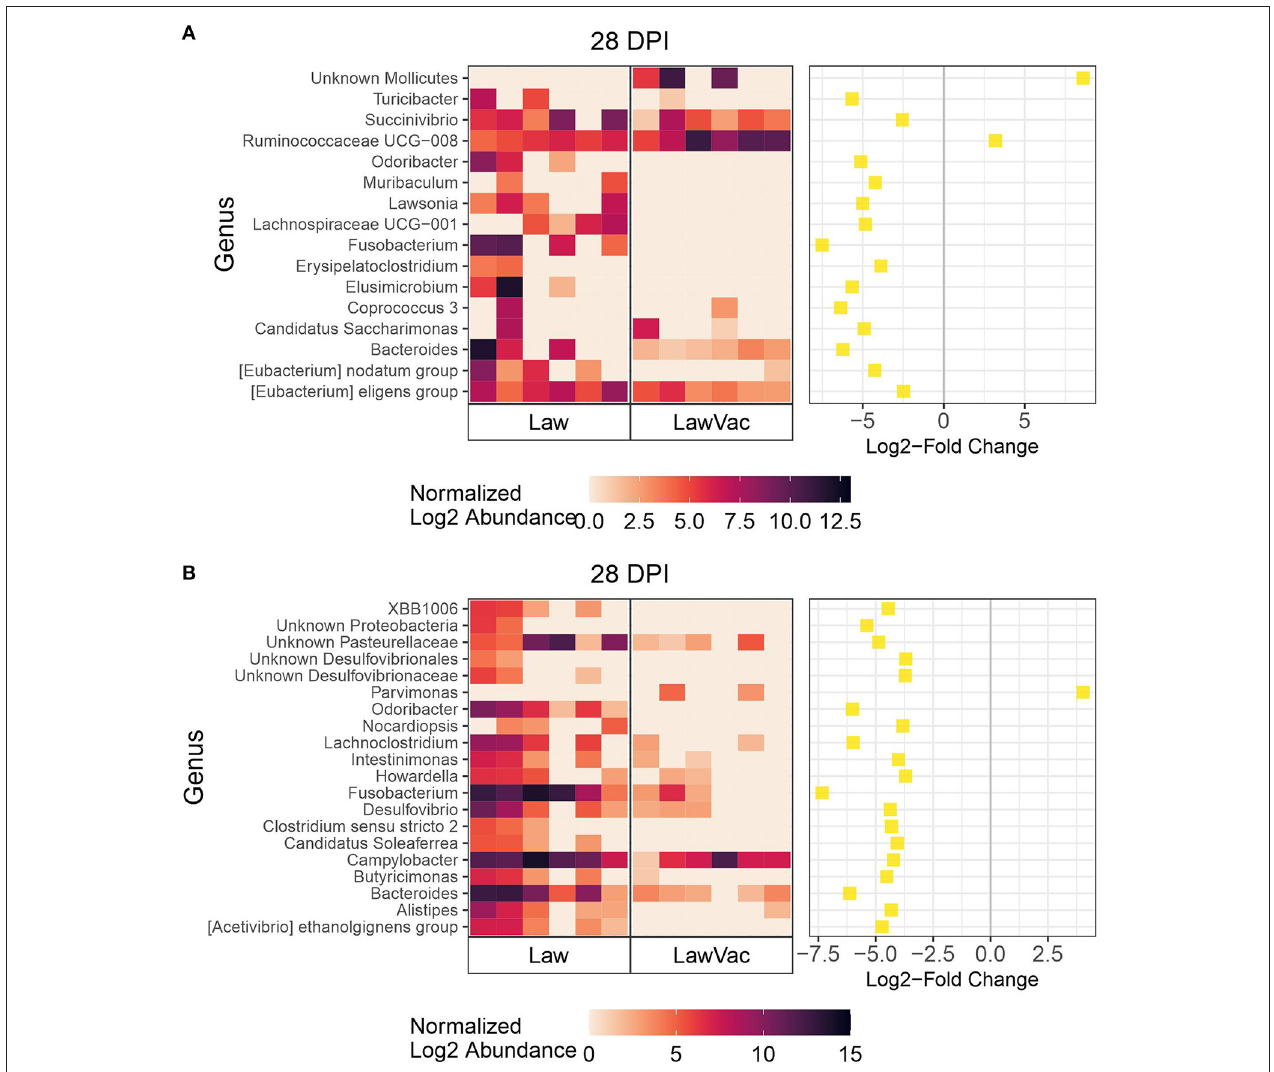
FIGURE 7 | Differential abundances of microbial genera between the Law and LawVac groups at 28 dpi in (A) fecal samples and (B) ileal mucosa samples. The 20 genera with the largest significant log2-fold change are included for ileal mucosa samples. The heatmap shows the cumulative sum scaling (CSS)-normalized log2 abundance of each genera per sample, with the significant log2-fold changes plotted on the right panel. A positive log2-fold change indicates greater abundance in the LawVac group, and a negative log2-fold change indicates greater abundance in the Law